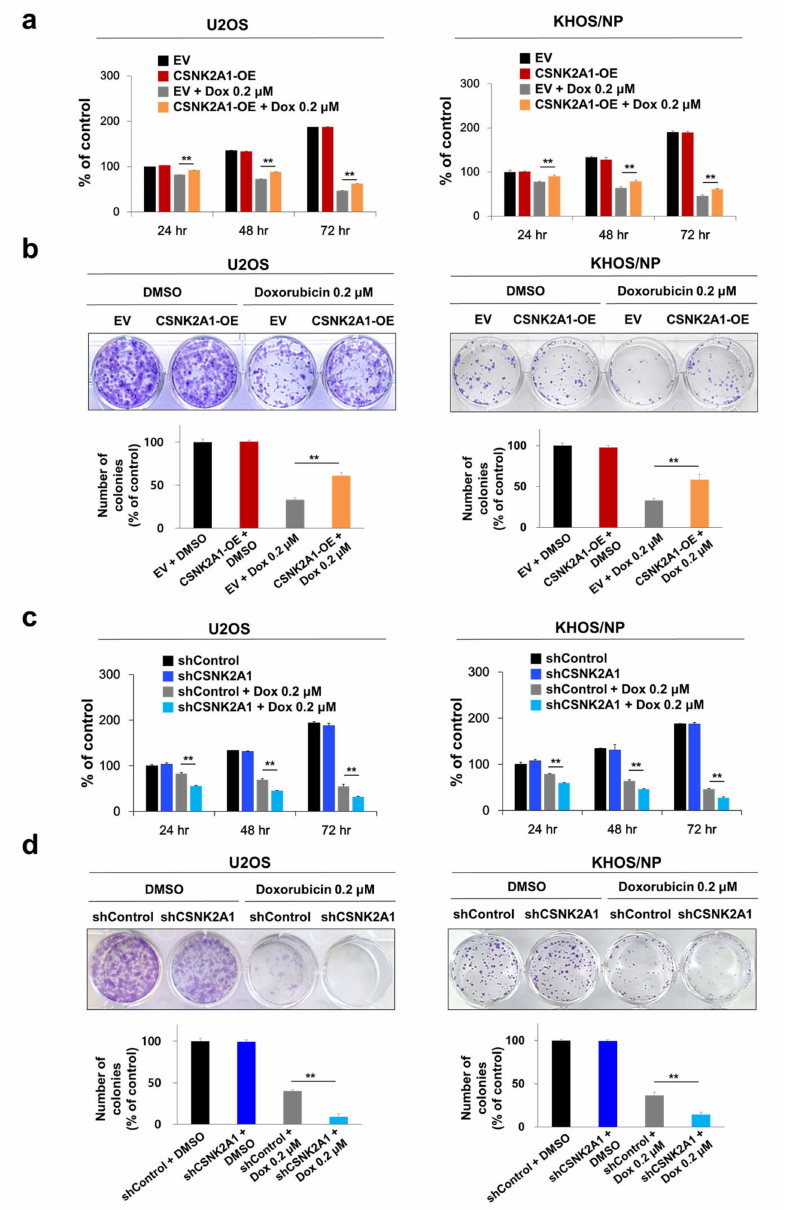
Figure 3. CSNK2A1 involvement in the effects of doxorubicin on the proliferation of osteosarcoma cells. ( a ) U2OS and KHOS/NP osteosarcoma cells were transfected with empty vector or wild-type CSNK2A1 and treated with doxorubicin (0.2 µ M) and then measured after 24, 48, and 72 h for proliferation with a CCK8 proliferation assay. ( b ) For the colony-forming assay, U2OS (1 × 10 3 ) and KHOS/NP (1 × 10 3 ) cells transfected with empty vector or wild-type CSNK2A1 were treated with DMSO or 0.2 µ M doxorubicin in 24-well culture plates. The cells were grown for ten days. Clono-Counter software was used in the quantification of the number of colonies. ( c ) U2OS and KHOS/NP osteosarcoma cells were transfected with control shRNA or shRNA for CSNK2A1 and treated with 0.2 µ M doxorubicin and then measured after 24, 48, and 72 h for proliferation with a CCK8 proliferation assay. ( d ) For the colony-forming assay, U2OS (1 × 10 3 ) and KHOS/NP (1 × 10 3 ) cells transfected with control shRNA or shRNA for CSNK2A1 were treated with DMSO or 0.2 µ M doxorubicin in 24-well culture plates. The cells were grown for ten days. Clono-Counter software was used in the quantification of the number of colonies. **; p <